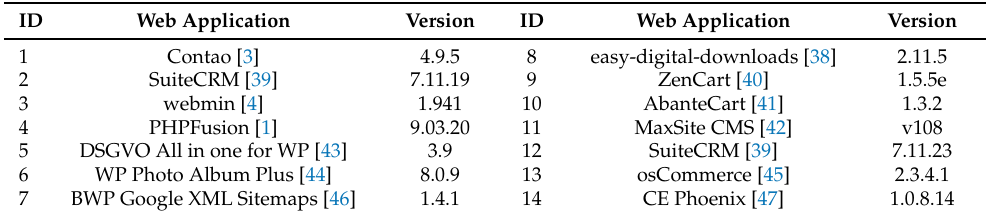
Table 4. Experimental